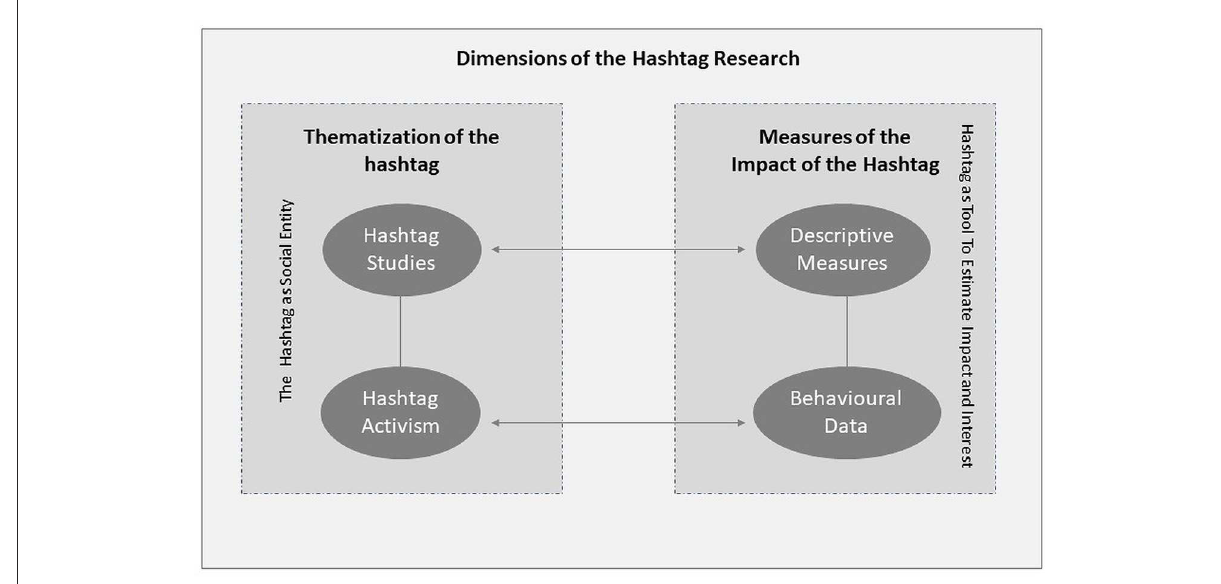
FIGURE1 Current dimensions of the hashtag research.